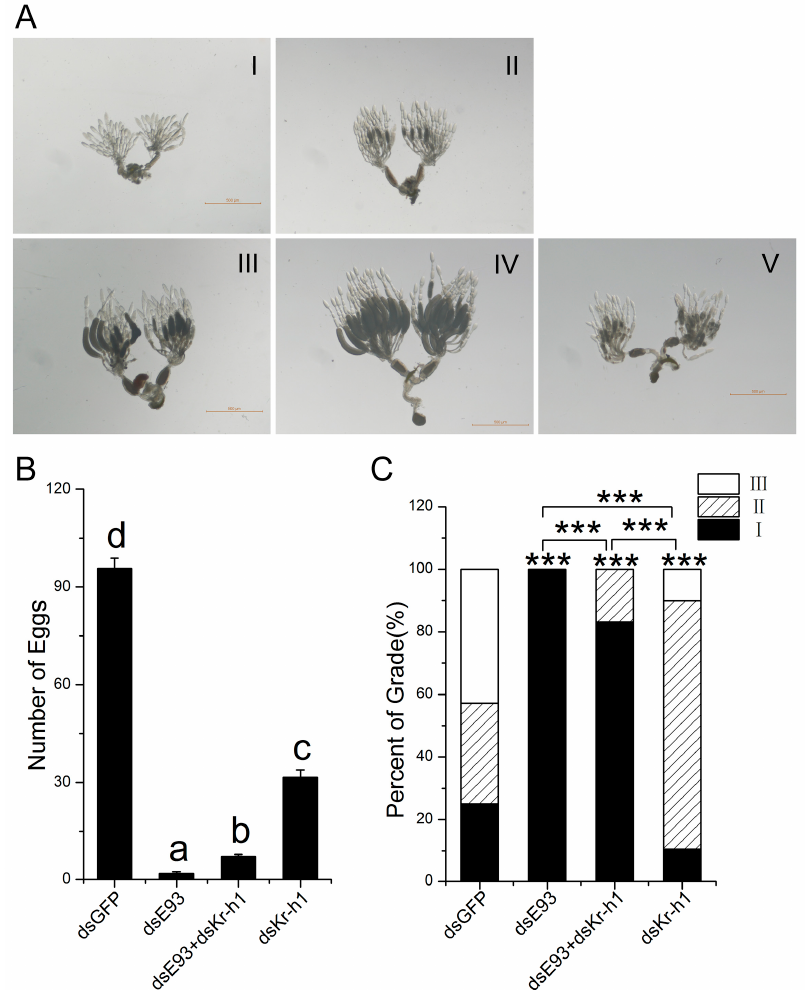
Figure 2. Downregulation of Kr-h1 partially recovered the deteriorating effect of E93 knock-down on ovary development. The 5th instar nymphs were injected with E93 and Kr-h1 alone or together. ( A ) ovary grades I to V,I: transparent stage, ovarian tubules are transparent, II: vitellogenesis stage, ovarian tubules are transparent to milky white, III: matured stage, milky white mature eggs appear at the base of the ovarian tubule, IV: egg-laying stage with full-developed ovary, V: Last stage of egg-laying, ovarian tubule atrophy and nearly no egg was laid; ( B ) the number of eggs per female (short-winged), Duncan’s multiple comparison was used, p < 0.05; ( C ) the ovary grade (short-winged). Ovary grading was carried out two days after eclosion. Ovary development of the treatment ( E93 and Kr-h1 , alone or together) and the control dsGFP were compared, and single and dual knock down of E93 and Kr-h1 were also compared. dsGFP was used as a control. A chi-square test was used, ***: p < 0.001. The “***” immediately above the column indicates the comparison between the treatment and the control dsGFP. The comparisons among treatments were indicated as specifically by transverse